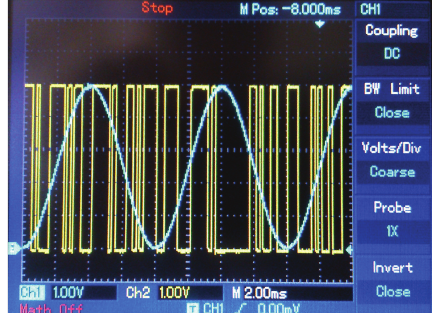
Figure 11: 125 Hz sine wave message. Blue: sent message. Yellow: encrypted message signal.